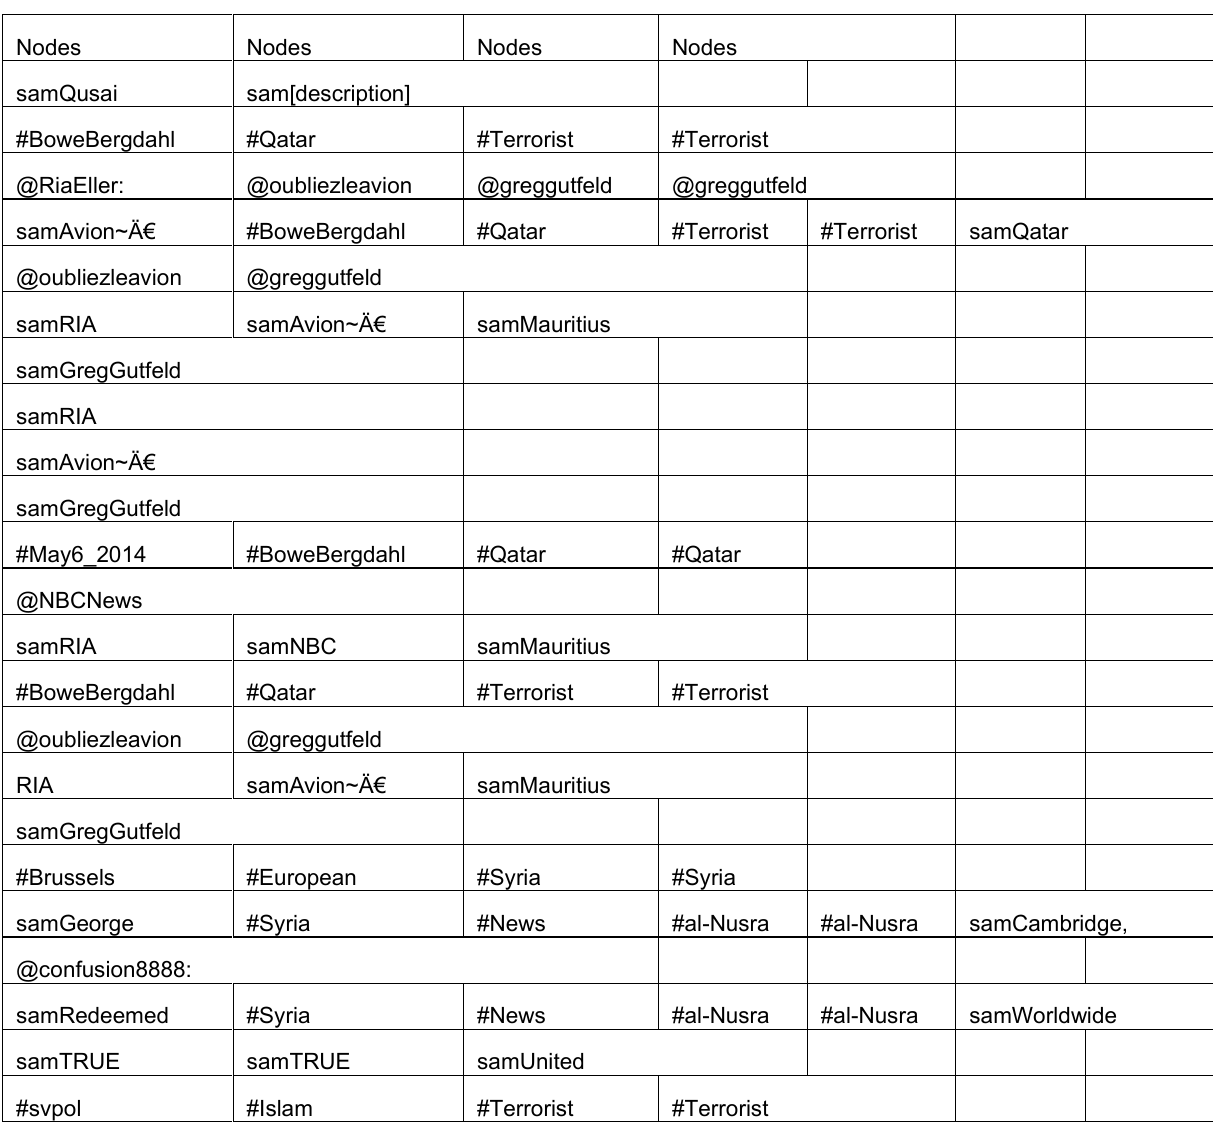
Table 1. Nodes of categorized Twitter Hashtags and